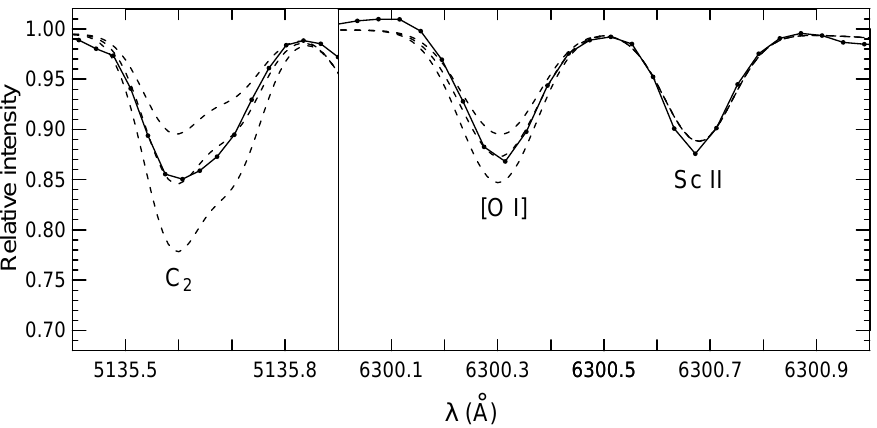
Fig. 4. Synthetic spectrum fits to the C 2 line at 5135.5 ˚A and the forbidden [O i ] line at 6300.3 ˚A. The observed spectra are shown as solid lines. The dashed lines are synthetic spectra with [C = Fe] = (cid:0) 0 : 03, 0.13 and 0.23 dex and [O = Fe] = 0 : 03, 0.13 and 0.23